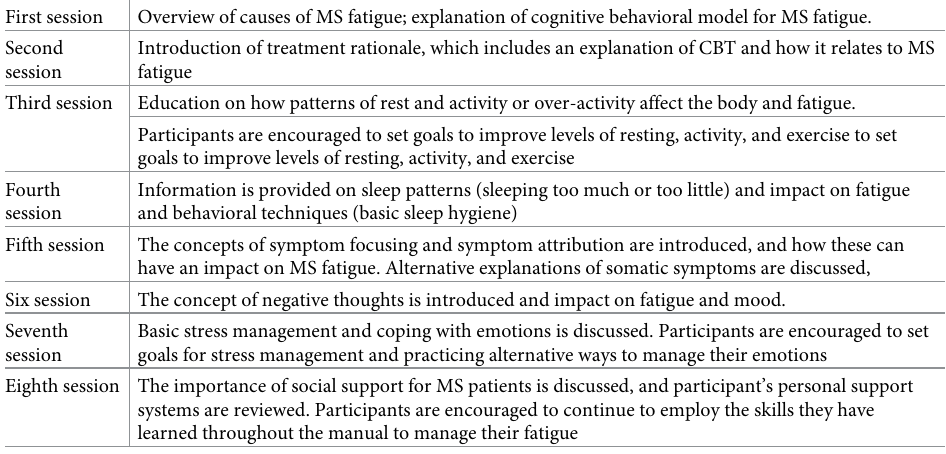
Table 1. Summary of CBT